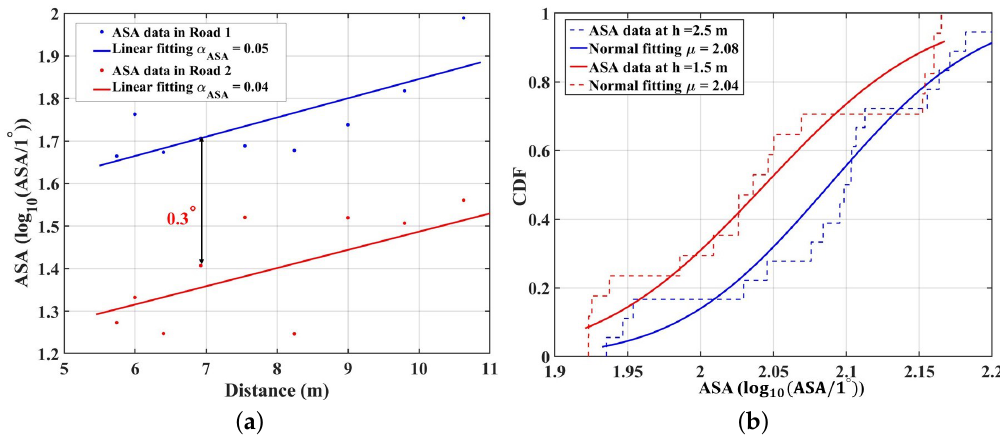
Figure 5. ( a ) The distance dependence of ASA samples under single TX case; ( b ) the CDF of ASA under the multiple TXs’ case in Road